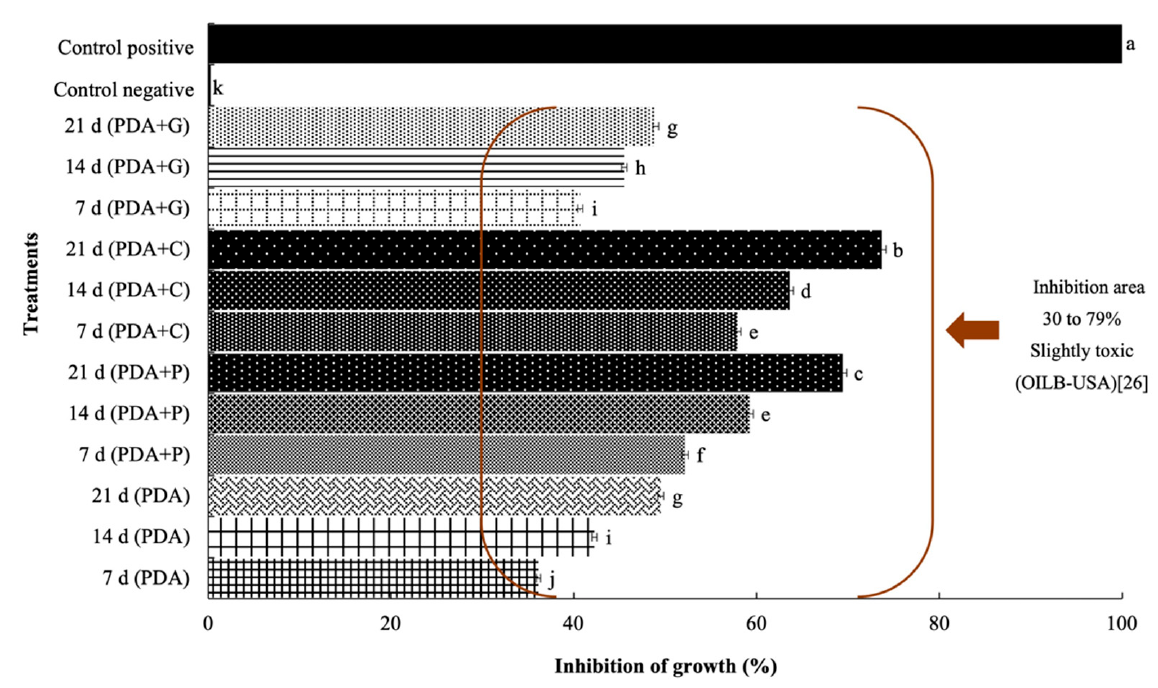
Figure 6. Percentage of inhibition for the growth of X. campestris pv. campestris due to the effect of cinnabarin from P. sanguineus in different media at 7, 14 and 21 days.